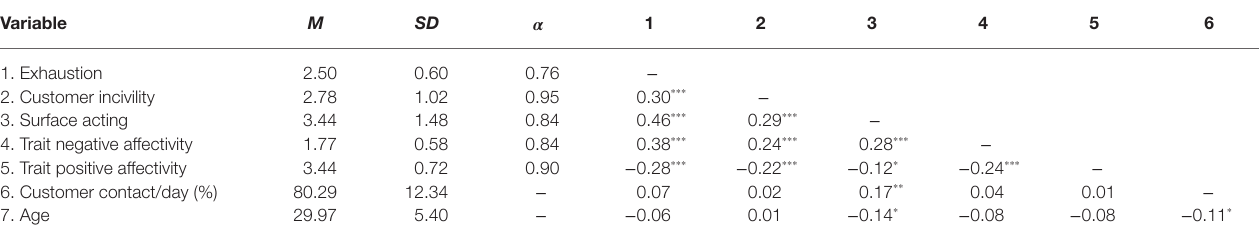
TABLE 1 | Study 1 means, standard deviations, intercorrelations, and internal-consistency reliability (Cronbach’s α ) of study variables. Variable M SD